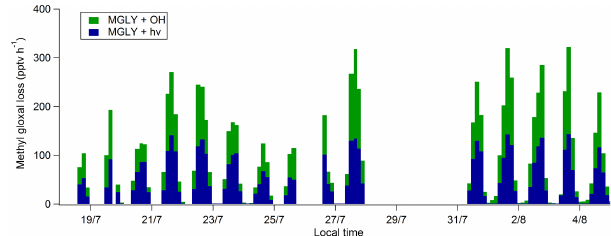
Figure 6. Time series of MGLY loss rates (pptvh − 1 ) from photol- ysis and reaction with